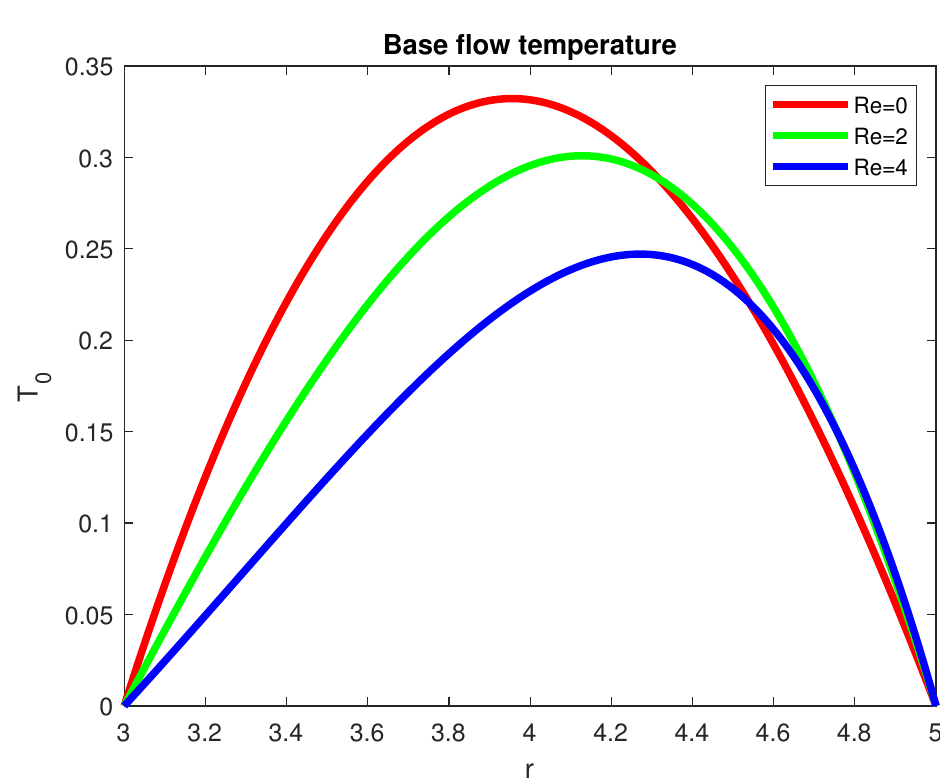
Figure 2. Base flow temperarture distribution for F = 0.5 and η =